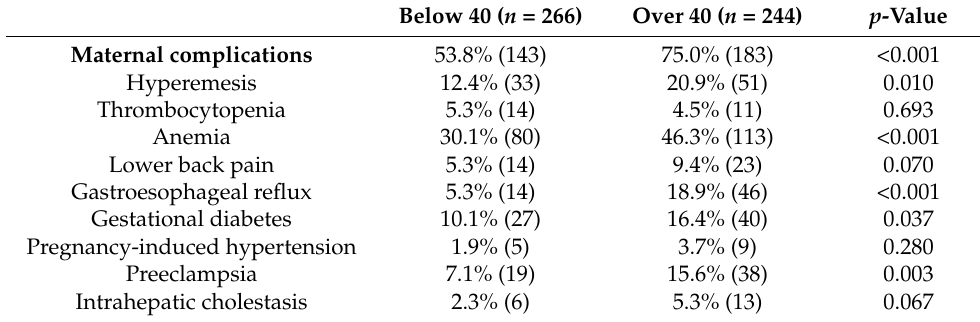
Table 2. Maternal and fetal complications during